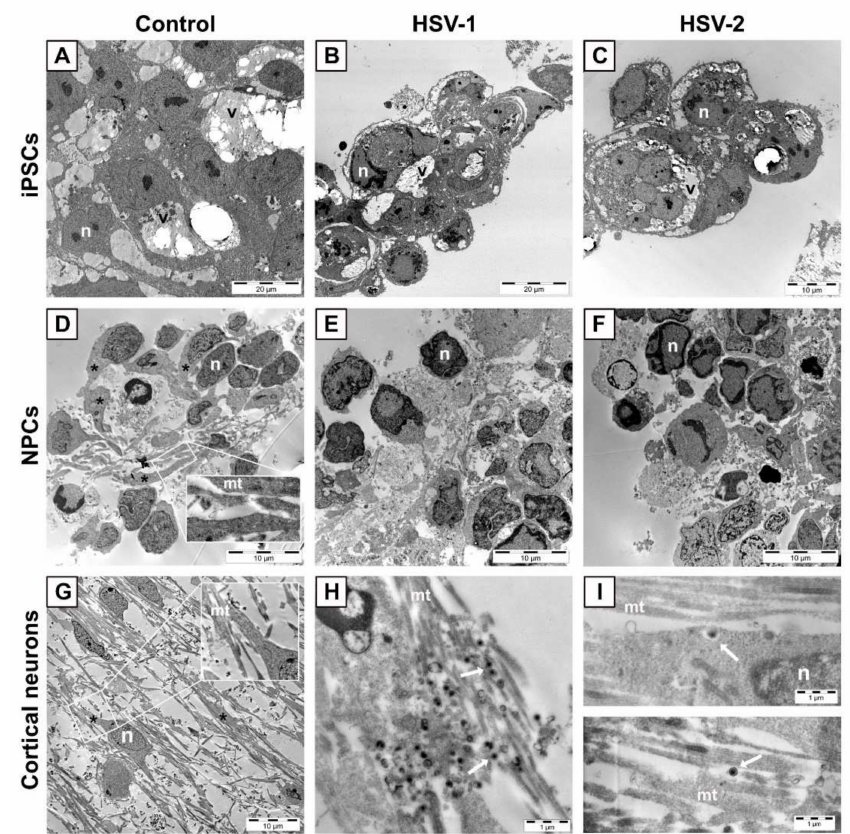
Figure 2. ( A – C ) Representative images of iPSCs uninfected or infected with HSV at MOI = 3. ( A ) Uninfected iPSCs. Large lipid-containing vacuoles (v) are observed in the cytoplasm of iPSCs, independent of infection. Infection of iPSCs with HSV-1 ( B ) or HSV-2 ( C ) induces cell rounding 16 h post-infection. ( D – F ) Representative images of NPCs uninfected or infected with HSV at MOI = 3. ( D ) Uninfected NPCs show long and wide extensions of the cytoplasm (asterisks) with clearly detectable microtubules (mt in inset) that are lost 24 h post-infection with HSV-1 ( E ) or HSV-2 ( F ). ( G – I ) Representative images of cortical neurons uninfected or infected with HSV at MOI = 3. Neurons display long projections (asterisk) containing microtubules (mt in, inset). These structures are relatively intact 42 h post-infection with HSV-1 ( H ) and 24 h post-infection with HSV-2 ( I ). n , nucleus; v, large lipid-containing